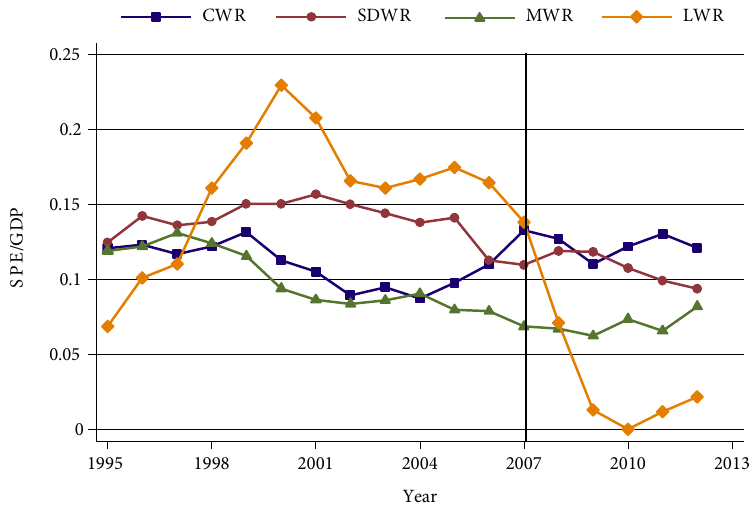
Fig. 1. Sigma convergence SPE/GDP in the EU–15 welfare state regimes, 1995–2012 Source: The authors’ estimation based on OECD 2013